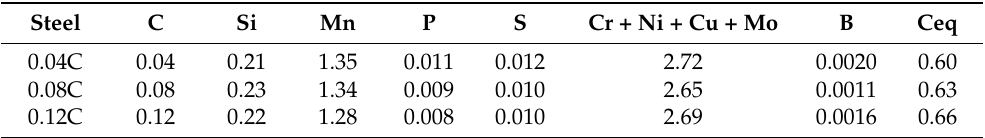
Table 1. Chemical composition of high-strength steels